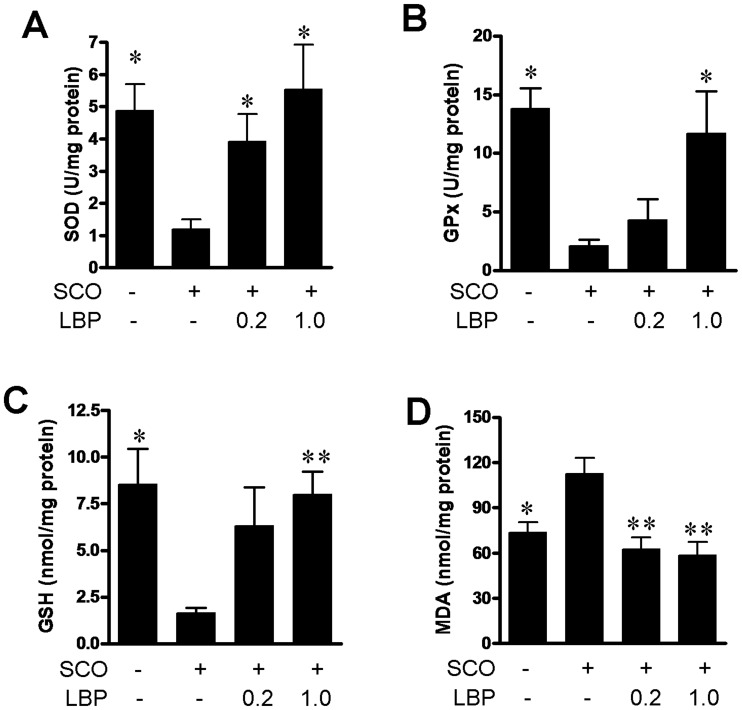
Anti-oxidative Effects of LBP in hippocampus.The SOD (A), GPX (B) specific activities, GSH (C) and MDA (D) levels were determined by using the rat hippocampus homogenates. Values are means ± SEM (n = 4 animals per group), *,P<0.05 and **,P<0.01 vs. SCO alone-treated group.